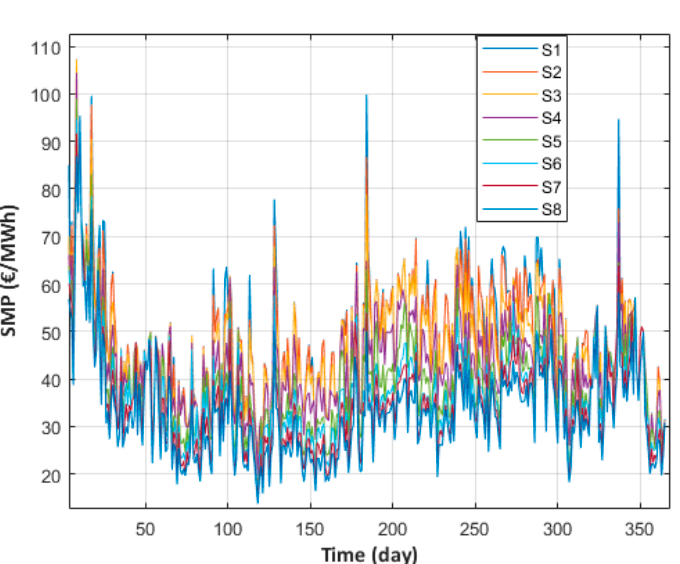
Figure 3. Daily average SMP per test day: ( a ) 2 January 2019, ( b ) 25 April 2019, ( c ) 14 August 2019, and ( d ) 9 October 2019. (source: Authors).